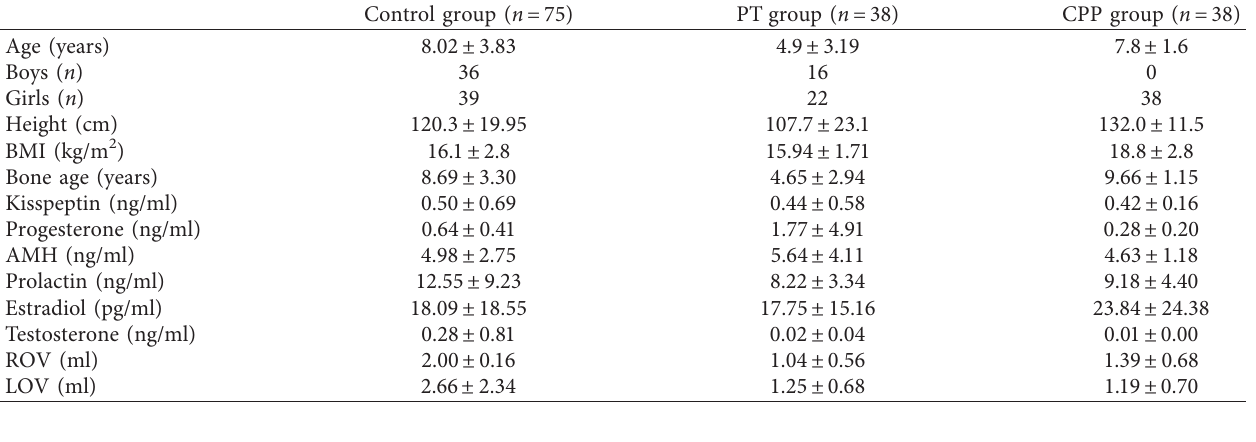
Table 1: General characteristics of the three groups.